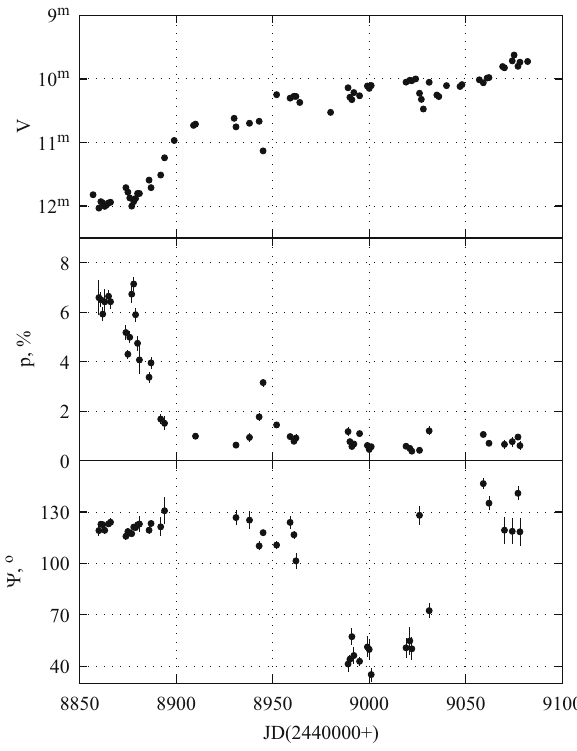
Figure 1: Magnitude ( top panel ) , polarization degree ( medium panel ) , and polarization position angle ( lower panel ) in the V band during UX Ori long - lasted deep eclipse ( Grinin et al . 1994 )